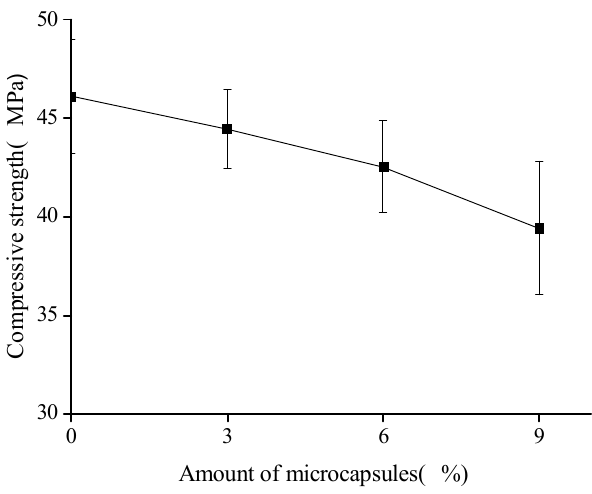
Figure 4. Variation in the compressive strength with the amount of microcapsules.